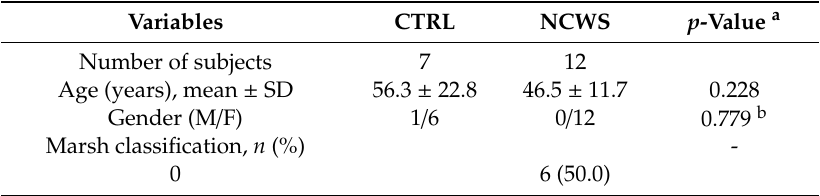
Table 1. Patients’